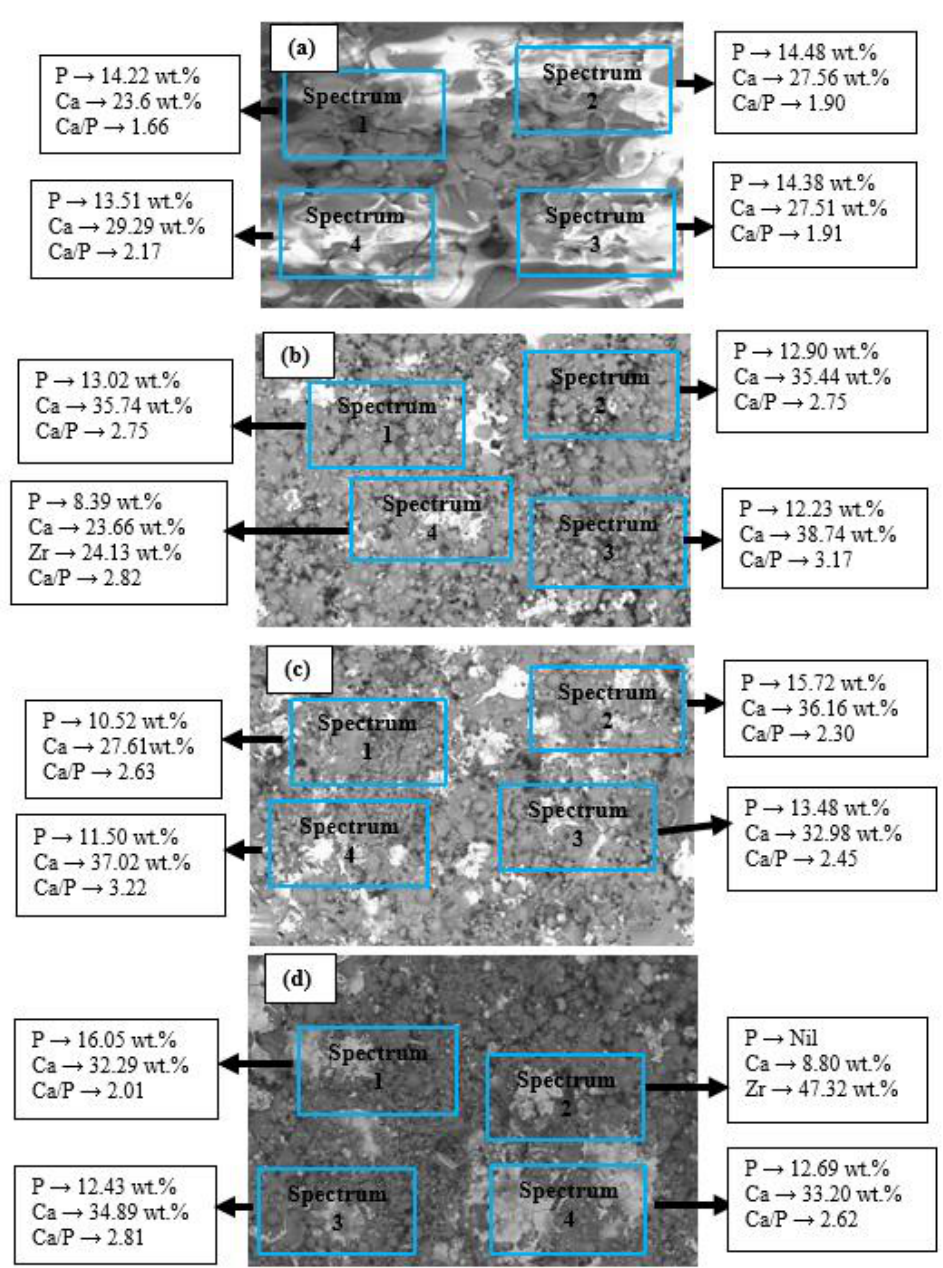
Figure 7. EDX analysis of FsHA with ( a ) 0 wt.% YSZ, ( b ) 10 wt.% YSZ, ( c ) 15 wt.% YSZ, and ( d ) 20 wt.% YSZ coatings on the Ti – 6Al – 4V substrate. ( d ) 20 wt.% YSZ coatings on the Ti–6Al–4V